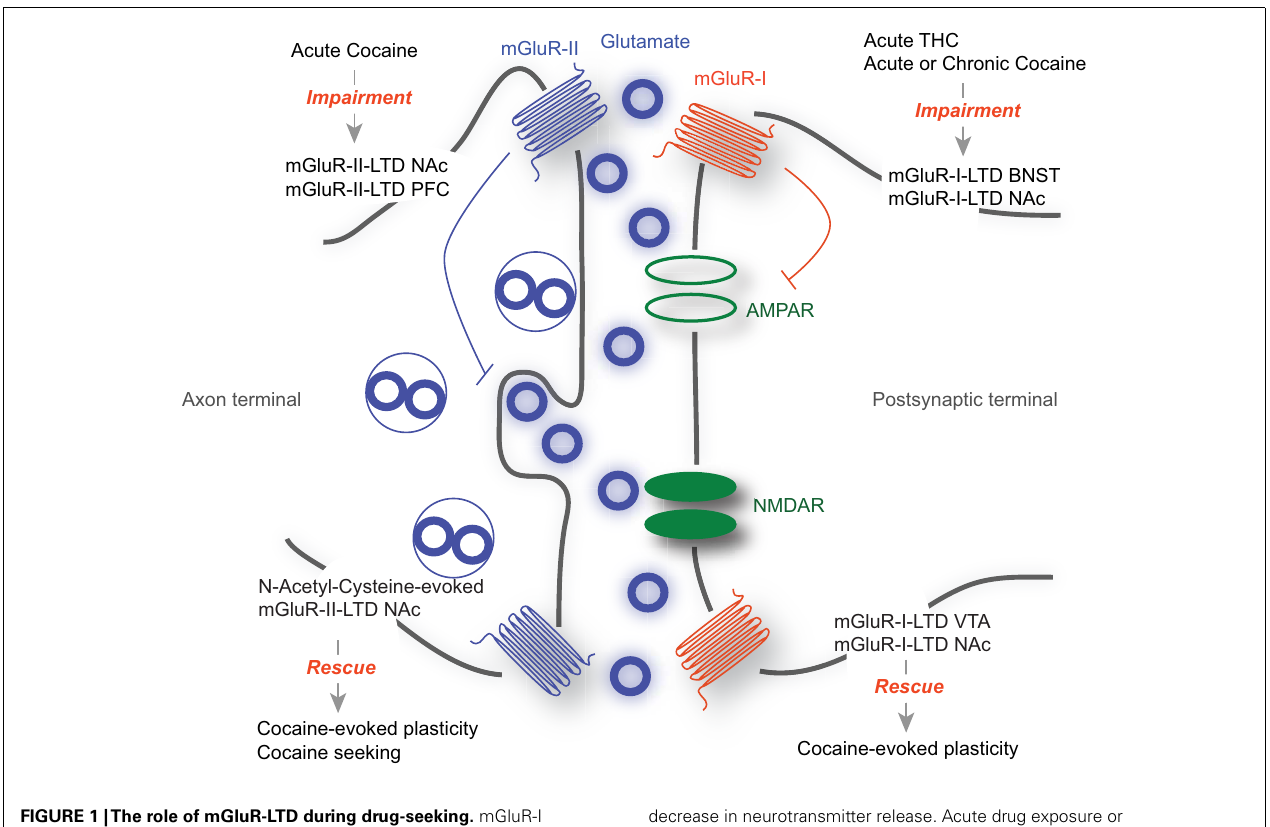
FIGURE 1 |The role of mGluR-LTD during drug-seeking. mGluR-I are mainly located at the postsynaptic membrane, while mGluR-II are mostly presynaptic.While mGluR-I-LTD has been extensively described as postsynaptic and occurring through the removal of AMPARs, mGluR-II LTD expression is presynaptic, involving a